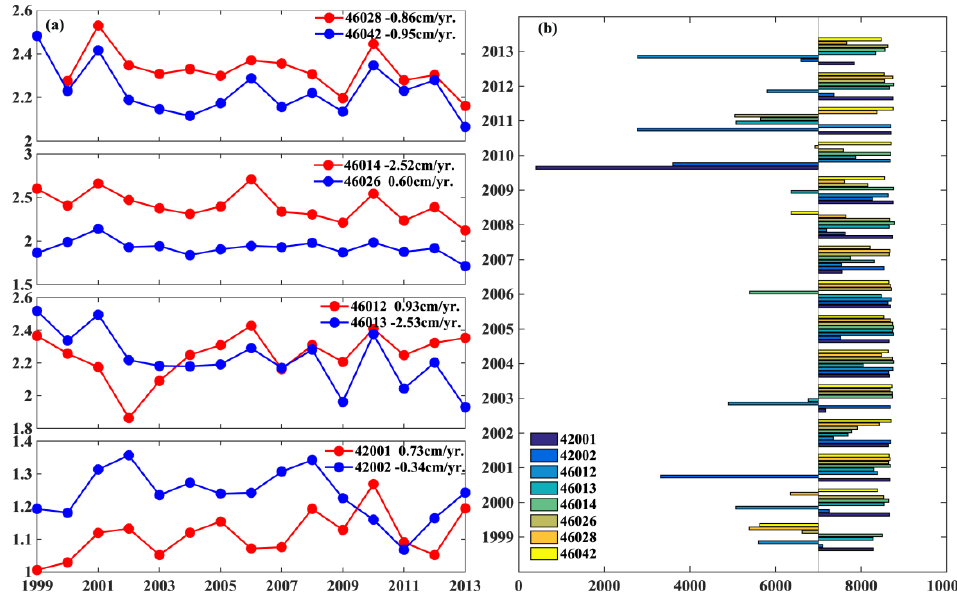
Table 2. Information on the data of buoys located near USA-Northeast and the Gulf of Mexico.